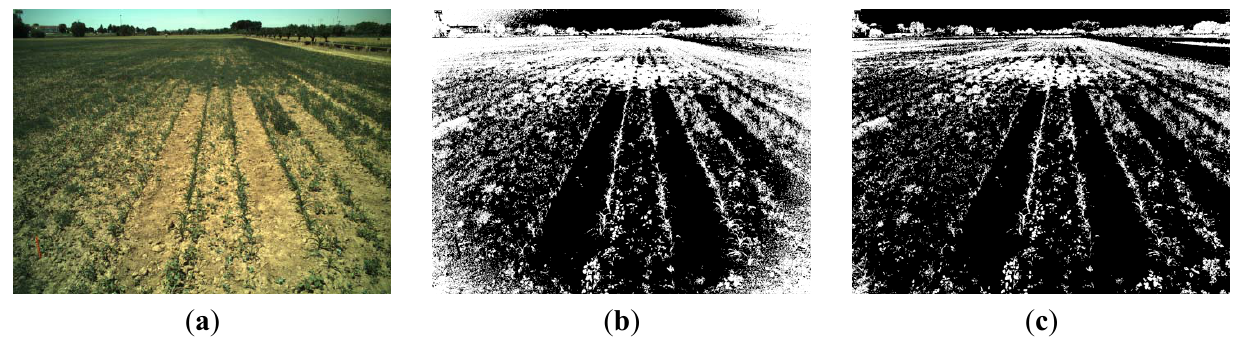
Figure 13. ( a ) Original image; ( b ) binary image without vignetting correction; ( c ) binary image with vignetting